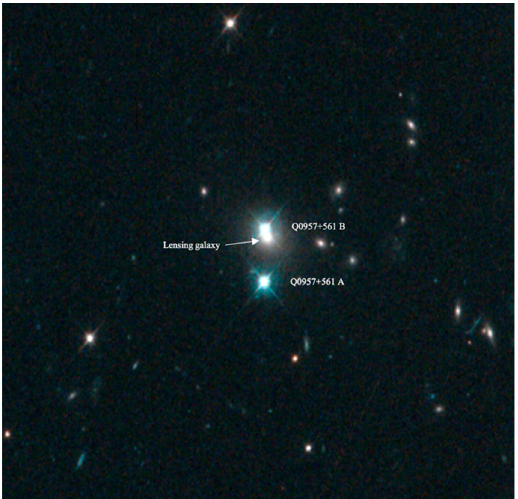
Figure 8. Components of double quasar QSO 0957+561 A and B) that are separated by 0.6 ′ ’. Image credit: NASA/ESA Hubble Space Telescope/G. Rhee, processed by W. Keel.